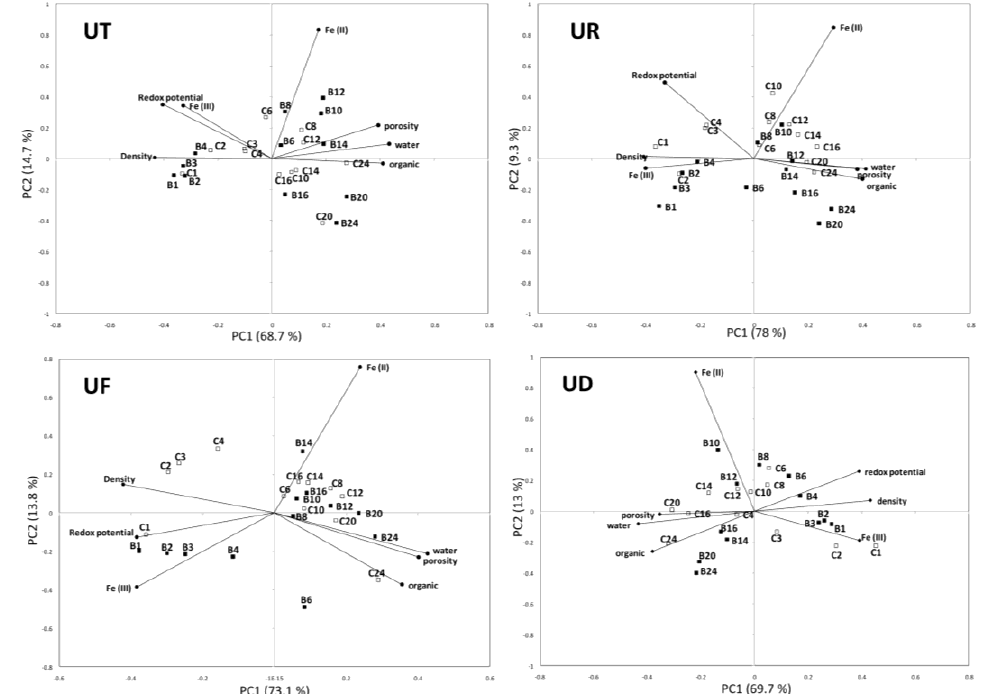
Figure 7. PCA biplot graph of sediment samples from burrowed and non-burrowed mudflats of U. triangularis (UT), U. rosea (UR), U. forcipata (UF) and U. paradussumieri (UD) habitat. Sediment samples from the burrowed plot indicated by the letter “B” and closed squares ( ■ ). Open squares (□) represent non-burrowed sediment samples (indicated with a “C” in graphs) and numbers refers to the depth layer (cm) of sediment samples.